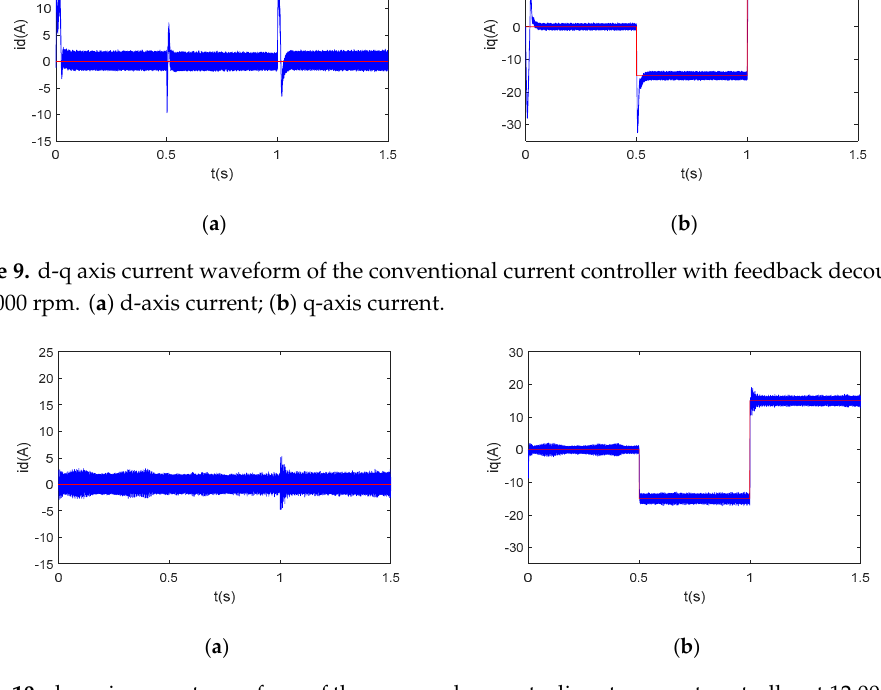
( a ) d-axis current; ( b ) q-axis Figure 10. d-q axis current waveform of the proposed accurate discrete current controller at 12,000